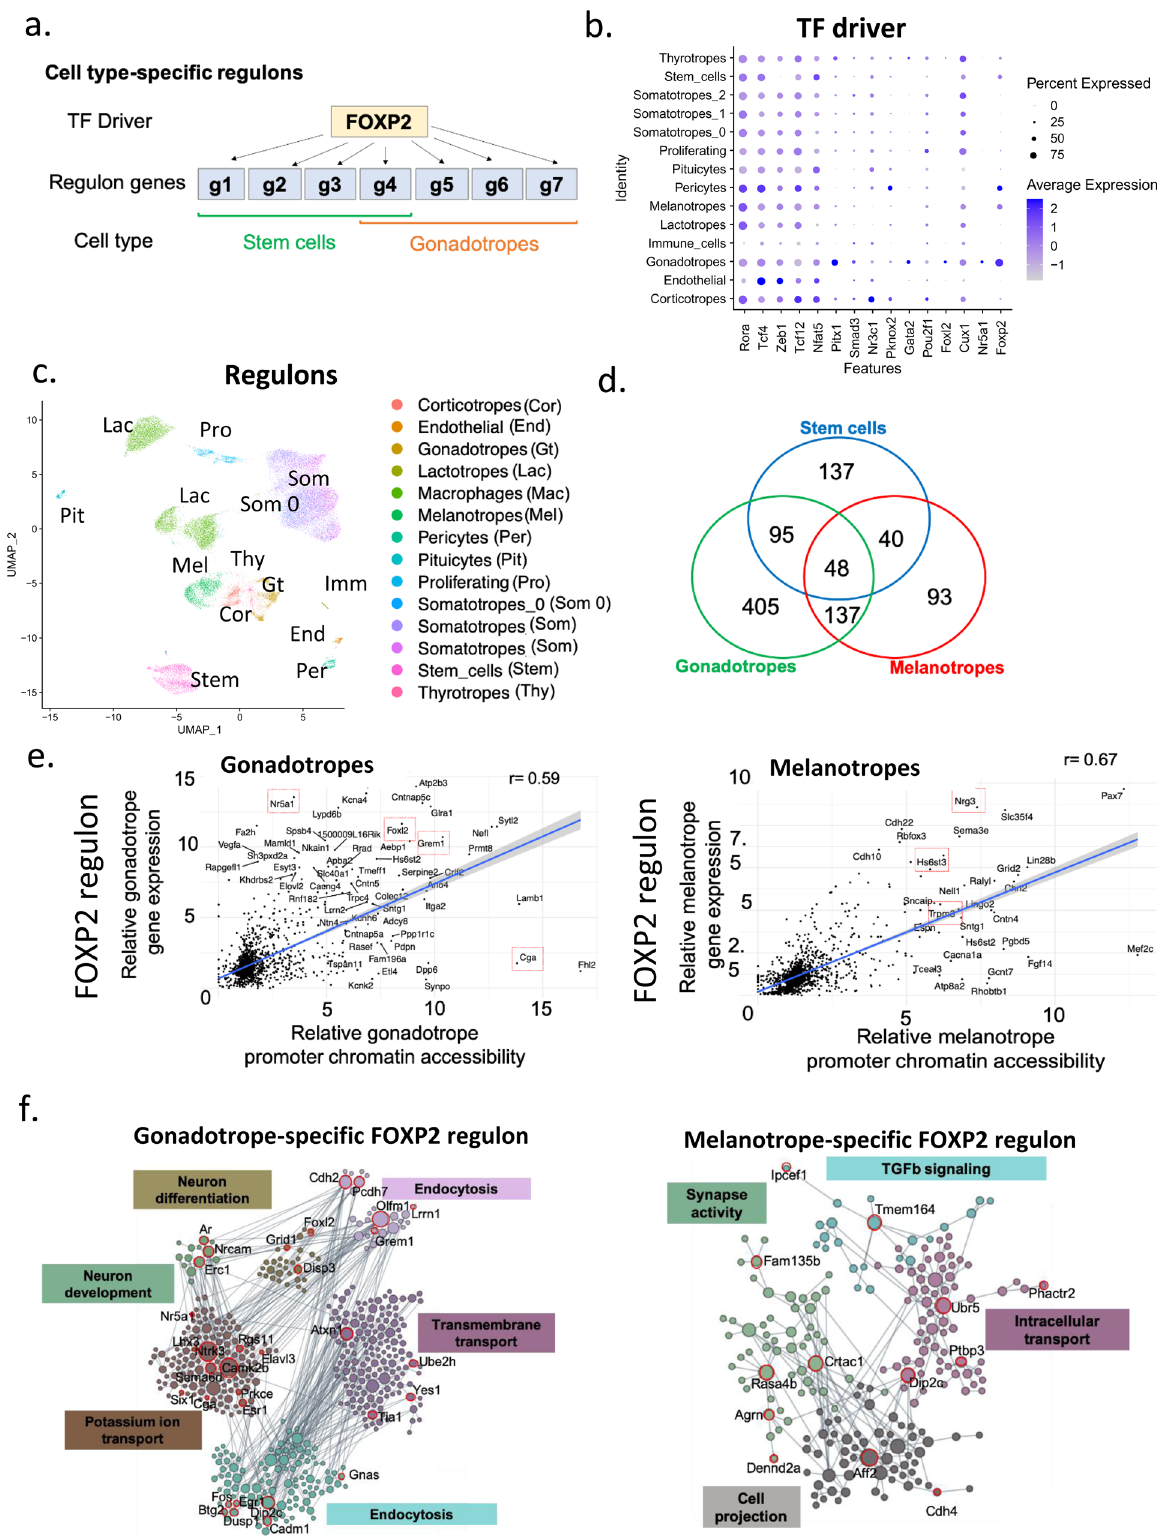
examined the differential expression of the driver genes in the different pituitary cell types. We found that some drivers are cell type-speci fi c ( Foxl2 in gonadotropes), whereas others are expressed in several cell types ( Foxp2 in gonadotropes, stem cells, melanotropes, pituicytes, and thyrotropes; Fig. 8b).